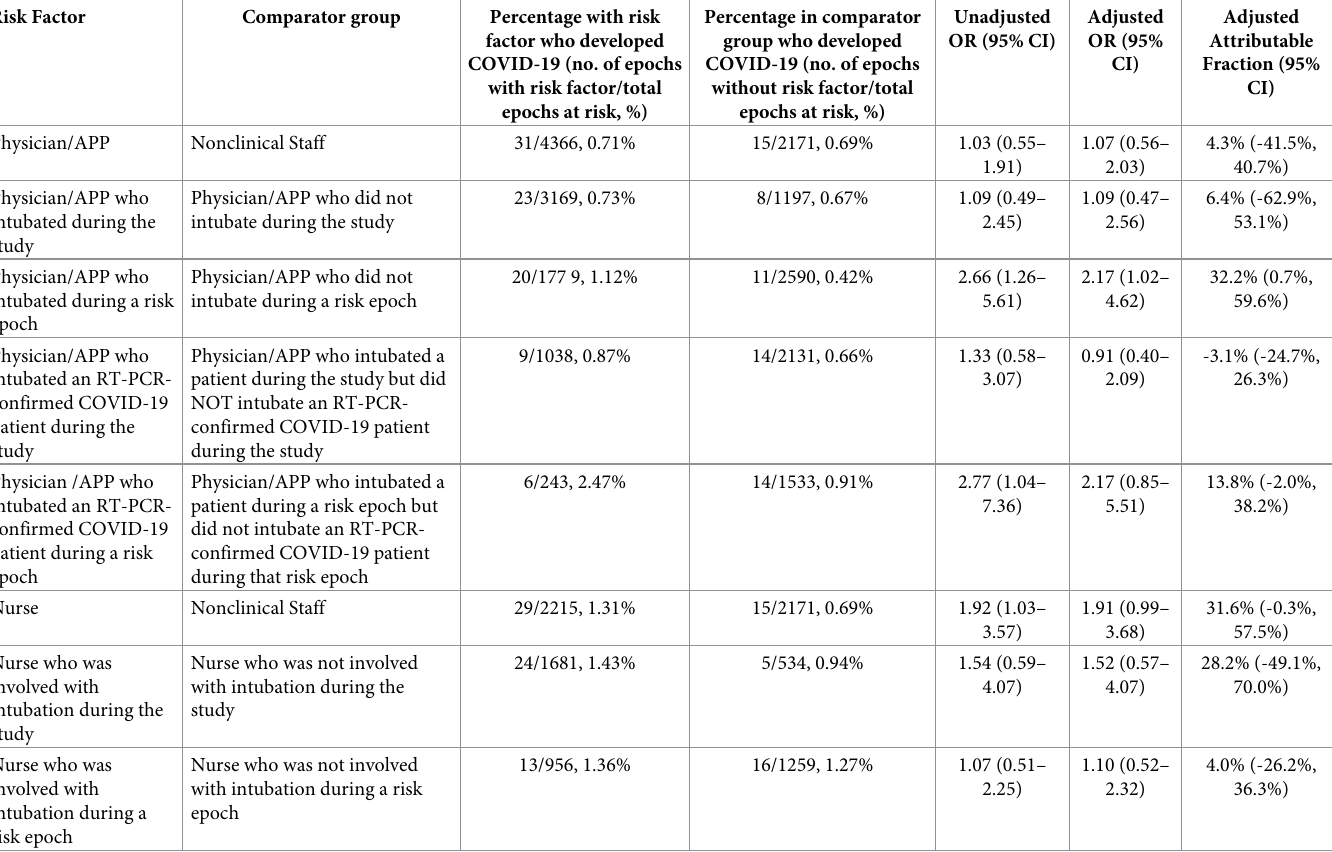
Table 2. Unadjusted and adjusted COVID-19 infection risk in emergency department health care personnel by exposure type, United States, May–December